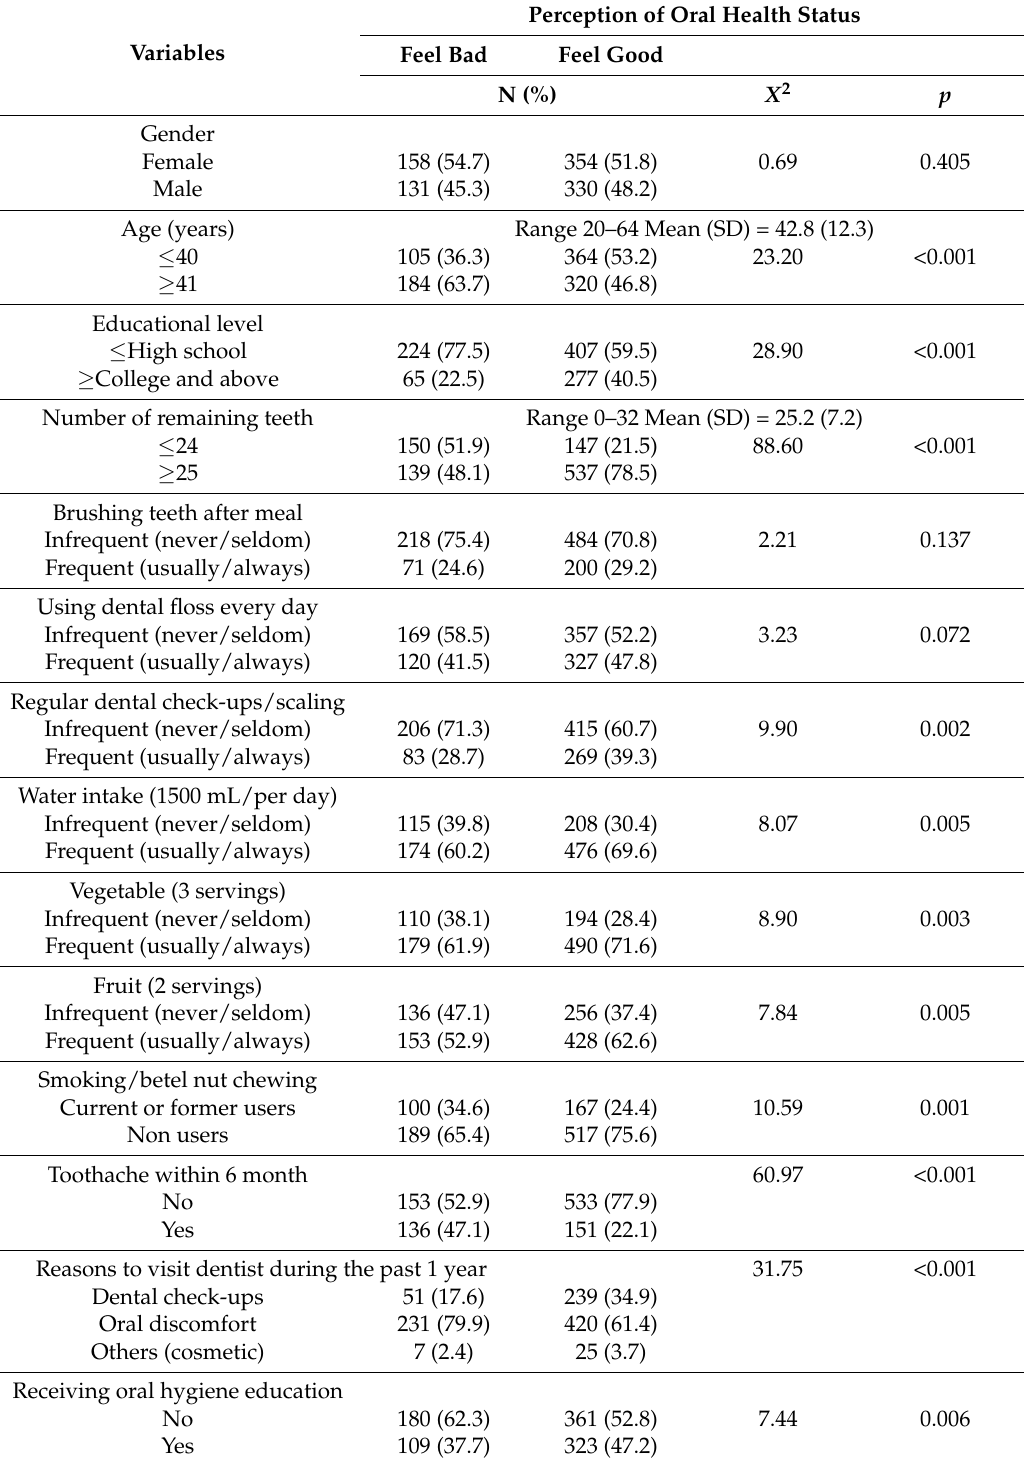
Table 1. Factors associated with perception of oral health status (N =